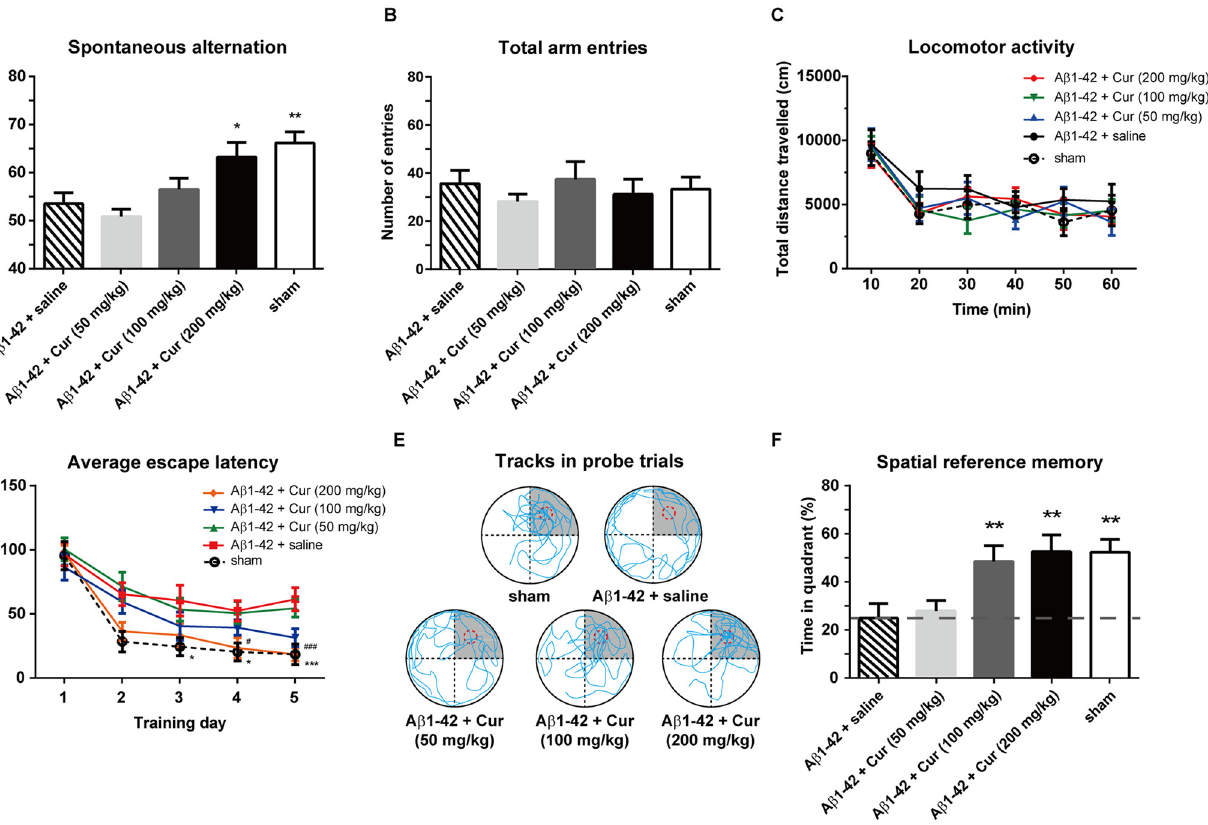
Fig 3. Effect of chronic curcumin treatment on working memory, motor function and spatial reference memory in Alzheimer's disease rats. (A) The spontaneous alteration in the Y-maze. (B) The total arm entries in Y-maze. (C) The total distance travelled in open-field test. (D) The escape latency during the water maze training trials. (E) Representative swim traces in the probe task. For panel D, * P < 0.05 and *** P < 0.0001 comparison between A β 1 – 42 + saline and sham; # P < 0.05 and ### P < 0.0001 comparison between curcumin (200 mg/kg) and A β 1 – 42 + saline. (F) The time spent in the target quadrant in the probe task. n = 8 each group. ** P < 0.01 and *** P < 0.0001 compared with A β 1 – 42 + saline.